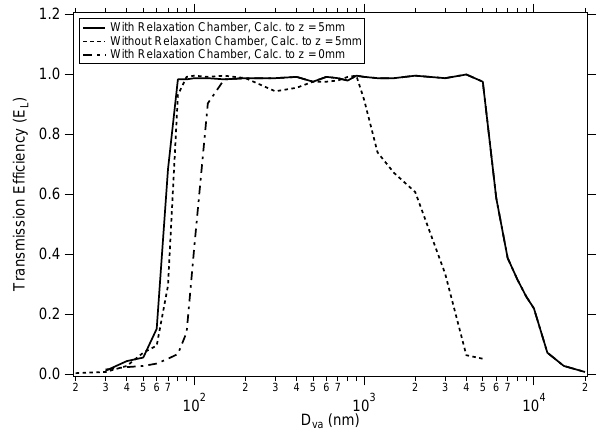
Fig. 3. Transmission efficiency ( E L ) calculated by the CFD model as a function of particle size with the relaxation chamber, calcu- lated to 5mm past exit nozzle ( z = 5, solid line), without the re- laxation chamber, calculated to 5mm past the exit nozzle ( z = 5, dashed line), and with the relaxation chamber, calculated to the exit nozzle ( z = 0, dash-dotted line).